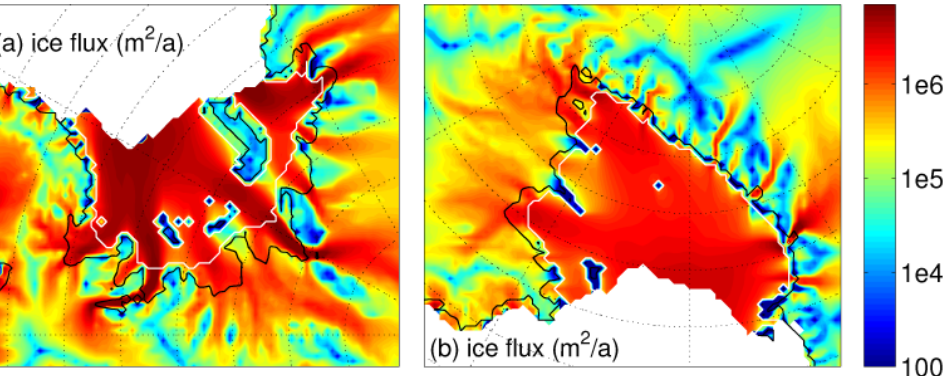
Fig. 12. Ice flux with streams indicated by black line for (a) Ronne-Filchner and (b) Ross Ice Shelves. The grounding line is marked by a white line.